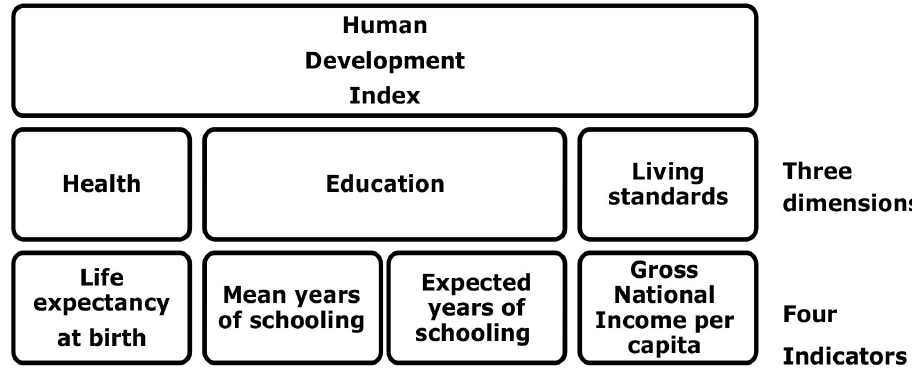
Figure 1. The HDI-three dimensions and